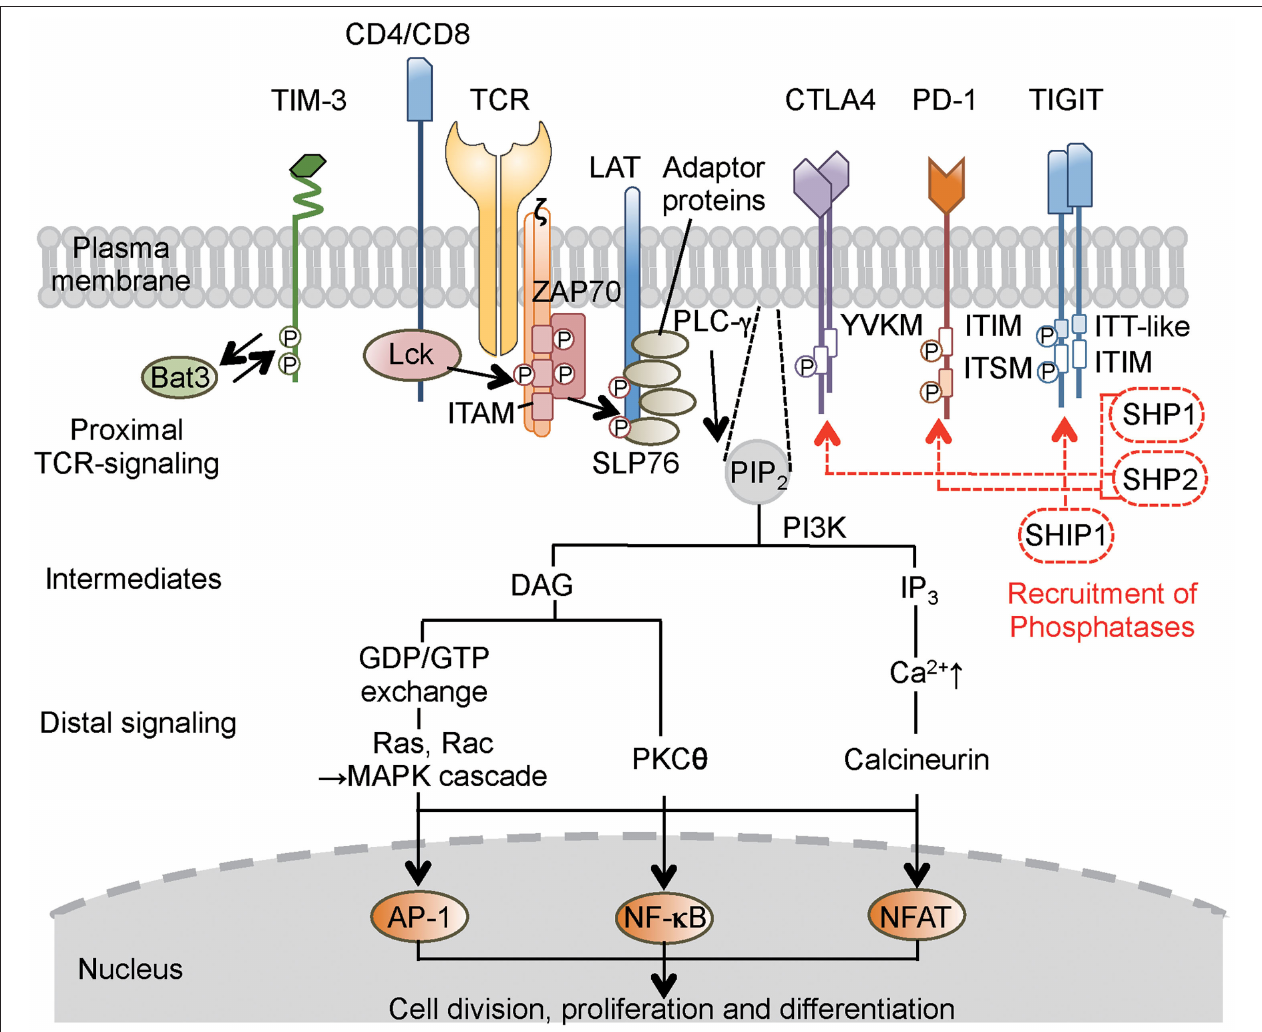
FIGURE 1 | Concise outline of the intracellular signaling events during T-cell activation and roles of co-inhibitory receptors. Binding of the TCR and co-receptors to peptide–MHC (major histocompatibility complex) complexes on the antigen-presenting cells (APCs) initiates proximal signaling events, which result in phosphorylation of the ζ chain, binding and activation of ZAP-70, phosphorylation of LAT and adaptor proteins, production of biochemical intermediates, and activation of distal signaling cascades. MAPK, PKC, and calcineurin are enzymes that activate transcription factors, thereby stimulating the expression of various genes involved in T-cell response. Most inhibitory receptors have an inhibitory motif, represented by ITIM, in their cytoplasmic tails. Ligand binding to these receptors results in the recruitment of phosphatases (SHP-1, SHP-2, or SHIP1), which alter proximal and distal TCR signals. These consequently transmit activating signal (black solid line arrow) and inhibitory signal (red broken line and arrow) in T cells. In the case of TIM-3, which does not have a classical signaling motif, Bat-3 (HLA-B associated transcript 3) binds to the TIM-3 tail and blocks binding of another adaptor molecule under steady state. Ligand binding triggers the dissociation of Bat-3 from the cytoplasmic tail of TIM-3, thus allowing another adaptor molecule to bind and promote the inhibitory function of TIM-3. CTLA4, cytotoxic T-lymphocyte-associated protein 4; PD-1, programmed cell death 1; TIM-3, T-cell immunoglobulin 3; TIGIT, T-cell immunoglobulin and ITIM domain; LAT, linker for activation of T cells; TCR, T-cell receptor; ZAP-70, ζ -associated protein of 70 kD; SLP-76, SH2-binding leukocyte phosphoprotein of 76 kD; ITIM, immunoreceptor tyrosine-based inhibitory motif; ITSM, immunoreceptor tyrosine-based switch motif; ITT, immunoglobulin tail tyrosine; SHP-1,-2, Src-homology-2 domain-containing protein tyrosine phosphatase 1, 2; SHIP1, SH2 domain-containing inositol-5-phosphatase 1; PIP 2 , phosphatidylinositol biphosphate; PI3K, phosphatidylinositol-3 kinase; DAG, diacylglycerol; IP 3 , phosphatidylinositol triphosphate; GDP/GTP, guanosine diphosphate/triphosphate; MAPK, mitogen-activated protein kinase; PLC, phospholipase C; PKC, protein kinase C; AP-1, activation protein 1; NF- κ B, nuclear factor- κ B; NFAT, nuclear factor of activated T